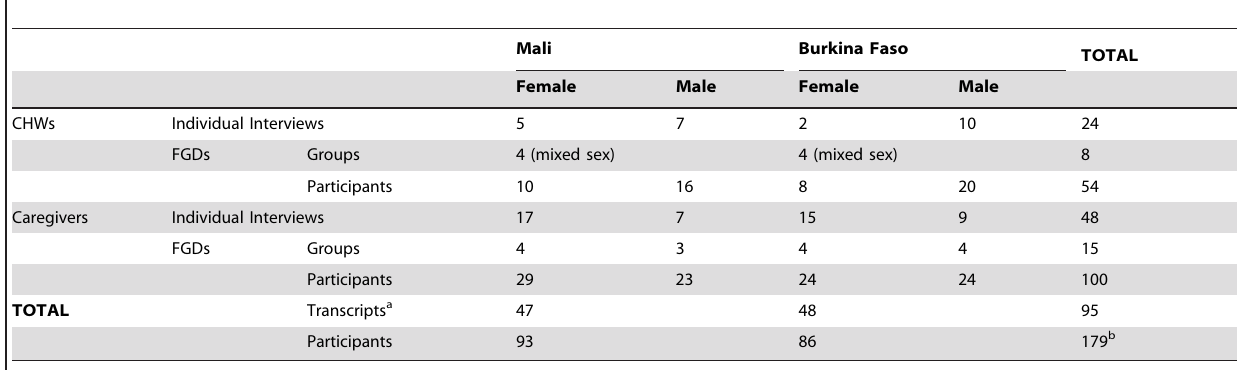
Table 1. Number of individual interviews, focus group discussions (FGDs), and participants by country and sex of participant.